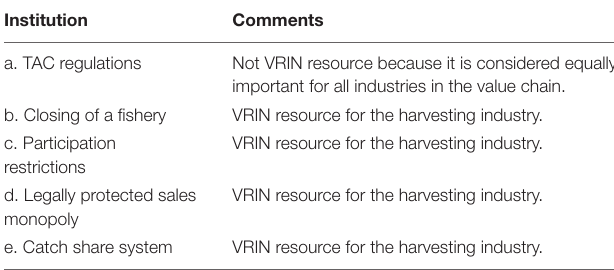
TABLE 4 | Institutions as VRIN resources in a seafood value chain.